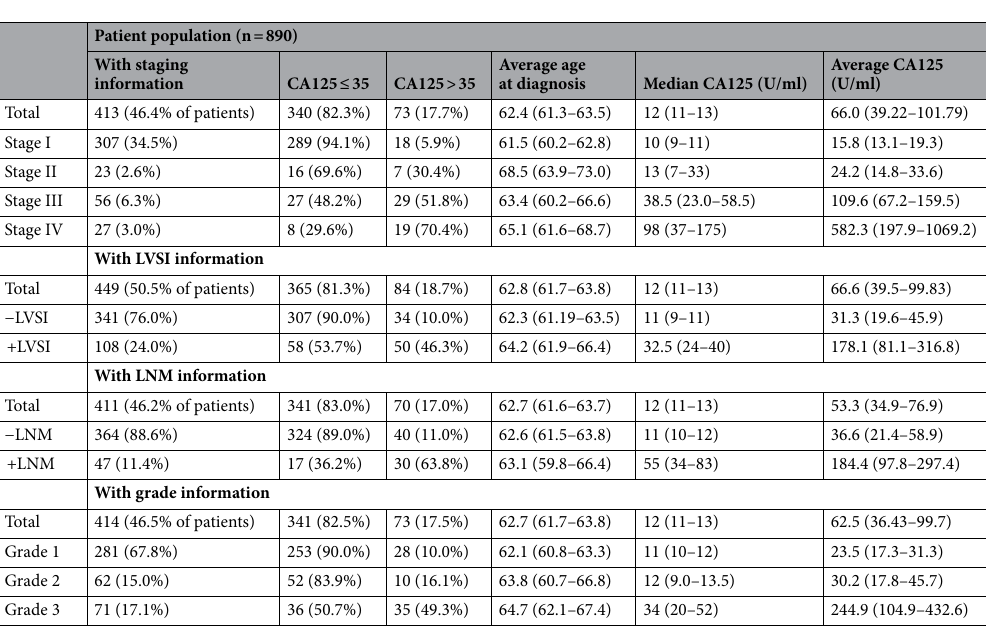
Table 1. Summary statistics of patient population. LVSI Lymphovascular space invasion, LNM Lymph node metastasis. 95% CI is shown in parentheses for Average Age at Diagnosis, Median CA125, and Average CA125.